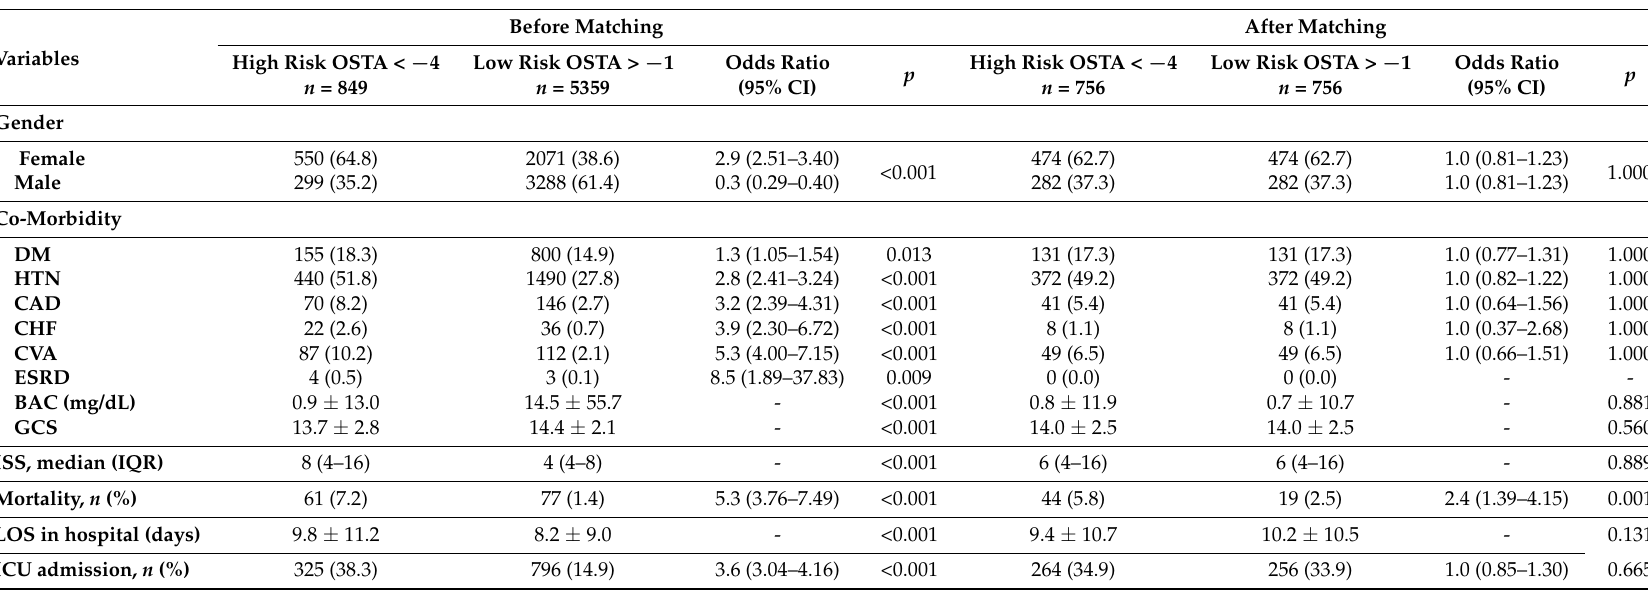
Table 3. Outcome of the high-risk and low-risk patients before and after propensity score-matching with adjustment of the covariates including gender, co-morbidity, BAC, GCS, and